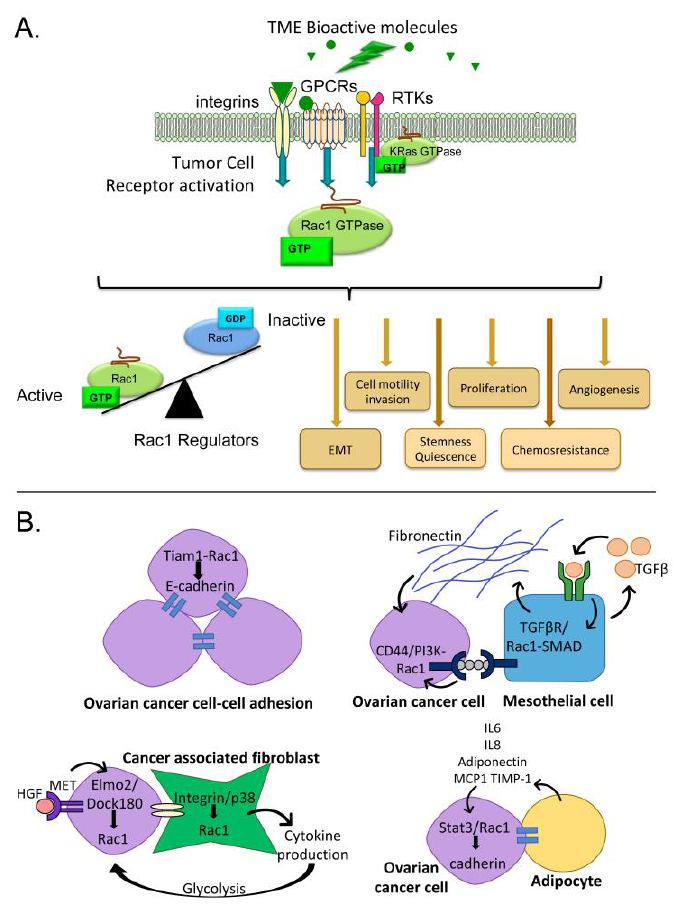
Figure 1. Bioactive molecules in the tumor microenvironment (TME) activate multiple receptors that converge on Rac1. ( A ) Examples of receptors that activate Rac1 in response to bioactive molecules in the TME are shown (GPCR = G protein-coupled receptor; RTK = receptor tyrosine kinase). Rac1 activity is balanced through multiple regulatory mechanisms discussed in this review that serve to control diverse physiological outcomes. ( B ) Cell-cell interactions between tumor cells themselves or with cells in the TME (adipocytes, cancer-associated fibroblasts, mesothelia) can also cause Rac1 activation and further modulate the TME. See Section 3.3 for further detail.